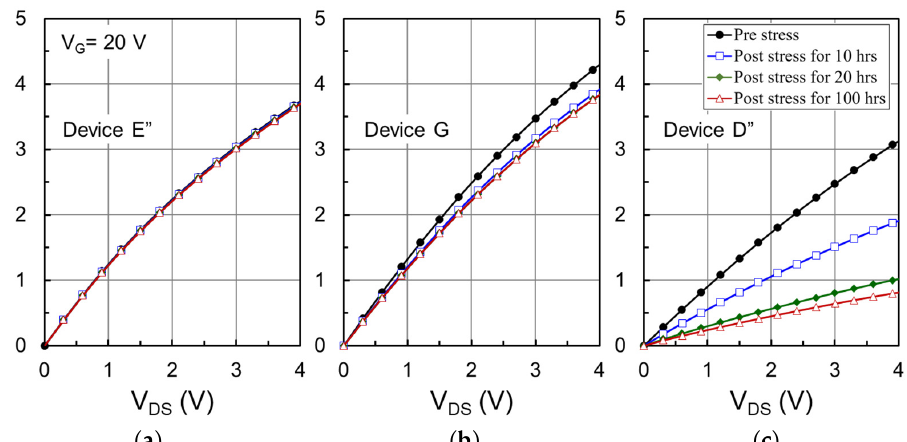
Figure 16. First quadrant I D –V D characteristics at gate voltage V GS = 20 V of 1.7 kV SiC DMOSFET from three vendors. The curves are shown before and after stressing the body diode at 5 A for ( a ) Device E” ( b ) Device G and 3.5 A for ( c ) Device D”.